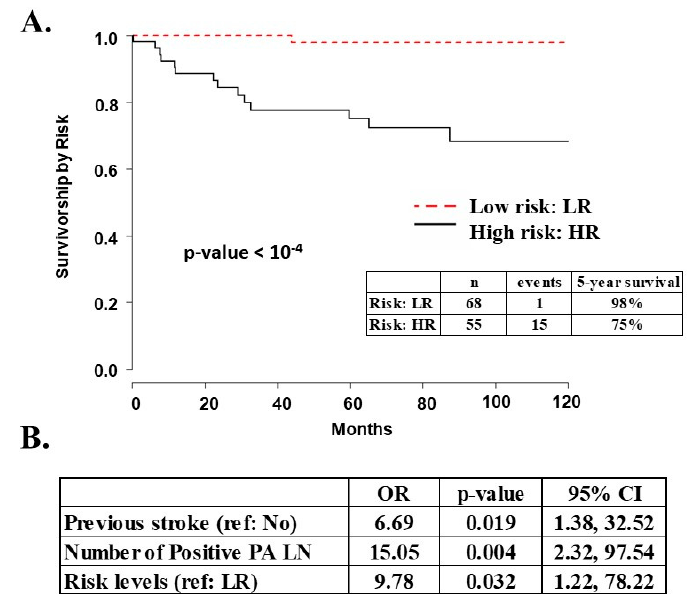
Figure 2. Survival analysis for UI EEC patients. ( A ) Survival curves for UI EEC patients with clinical data stratified by risk. There were two low risk and one high risk patients with no survival information; ( B ) Independent variables associated with survival in the multivariate analysis for UI EEC patients. Ref: reference value; PA LN: Para-aortic lymph nodes; LR: low risk. High risk patients have almost 10 times greater risk of dying from endometrial cancer relative to low risk patients.